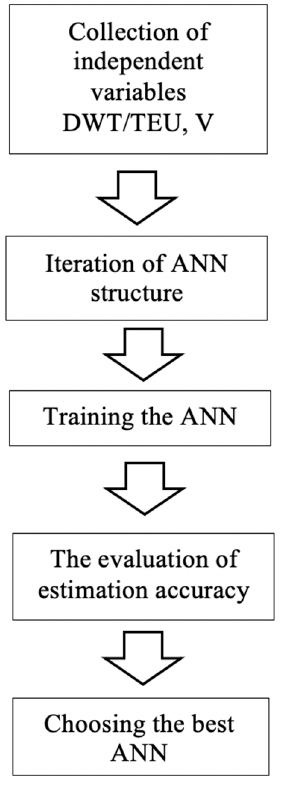
Figure 2. A general research framework.